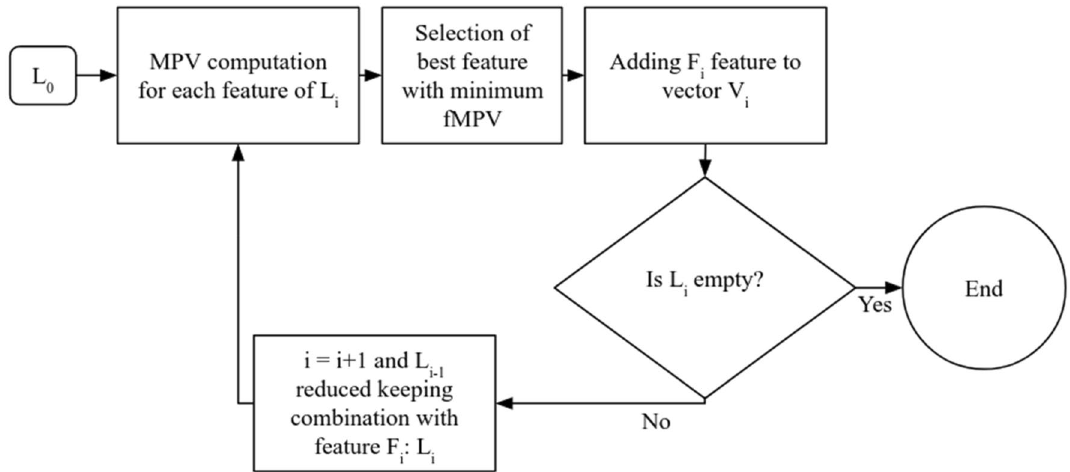
Figure 4. Flowchart of the proposed feature aggregation scheme (second selection step). L 0 was the list of all the combinations tested during brute-force searching based on feature families selected. L i represented the list of remaining combinations at iteration i . F i represented the feature with the lowest fMPV at iteration i . V i represented the feature vector at iteration i (for i = 0, V i is empty) 51